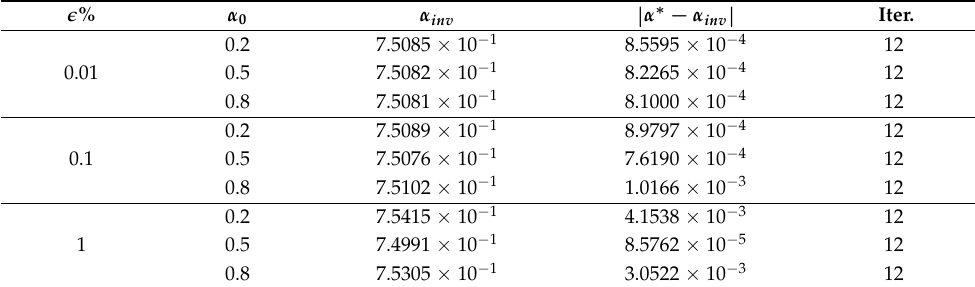
Table 6. Numerical observation of different α ∗ = 0.75 with data contaminated with (cid:101) % of noise in Test 4.